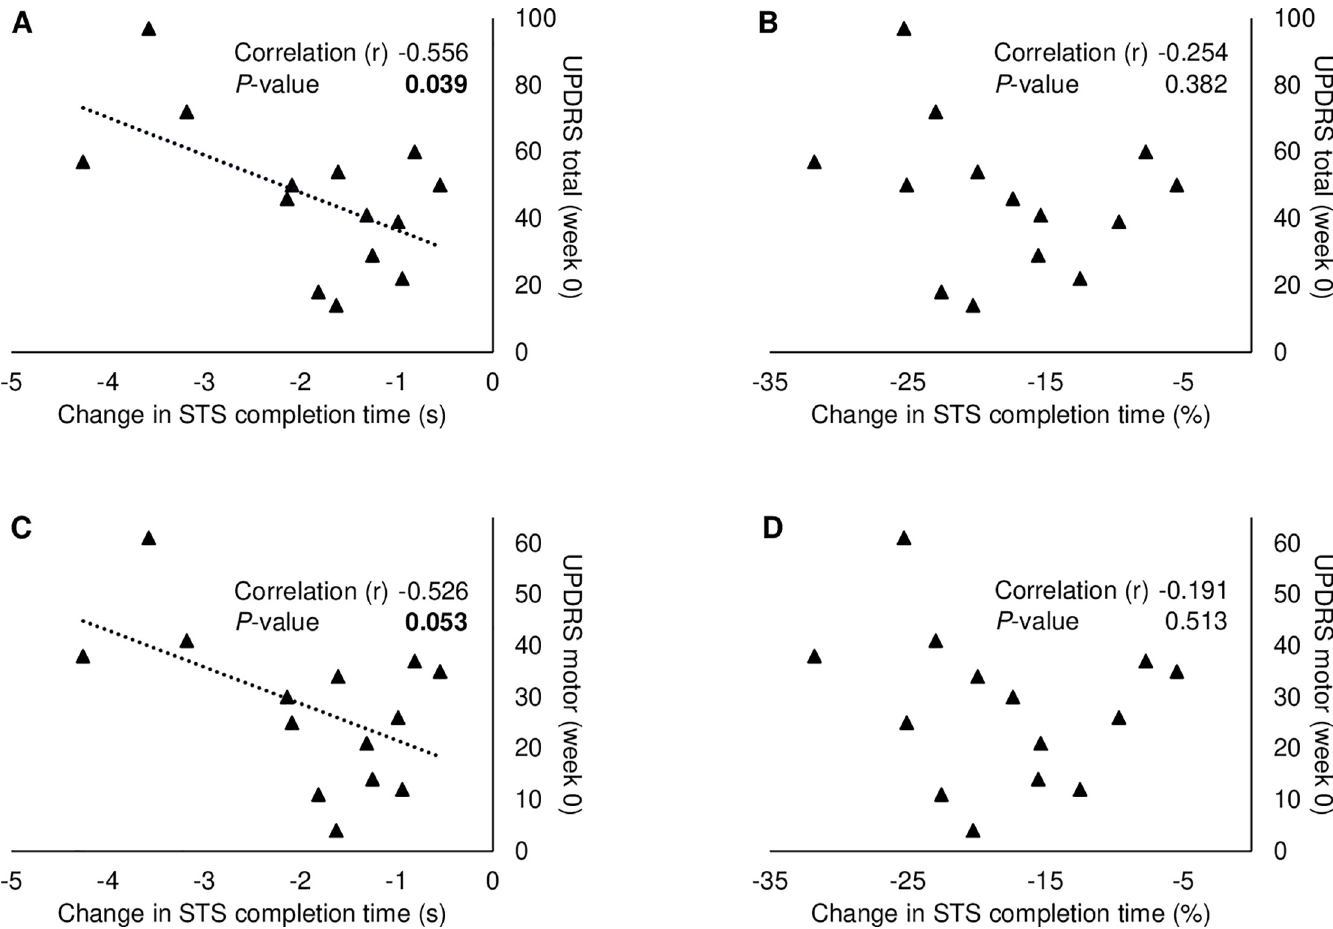
Fig 3. Association between disease severity and change in sit-to-stand completion time from week 0 to week 27 in the T-PEMF group. Pearson correlations between UPDRS total score and the absolute (A) and relative (B) change of completion time, and between UPDRS motor score and the absolute (C) and relative (D) change of completion